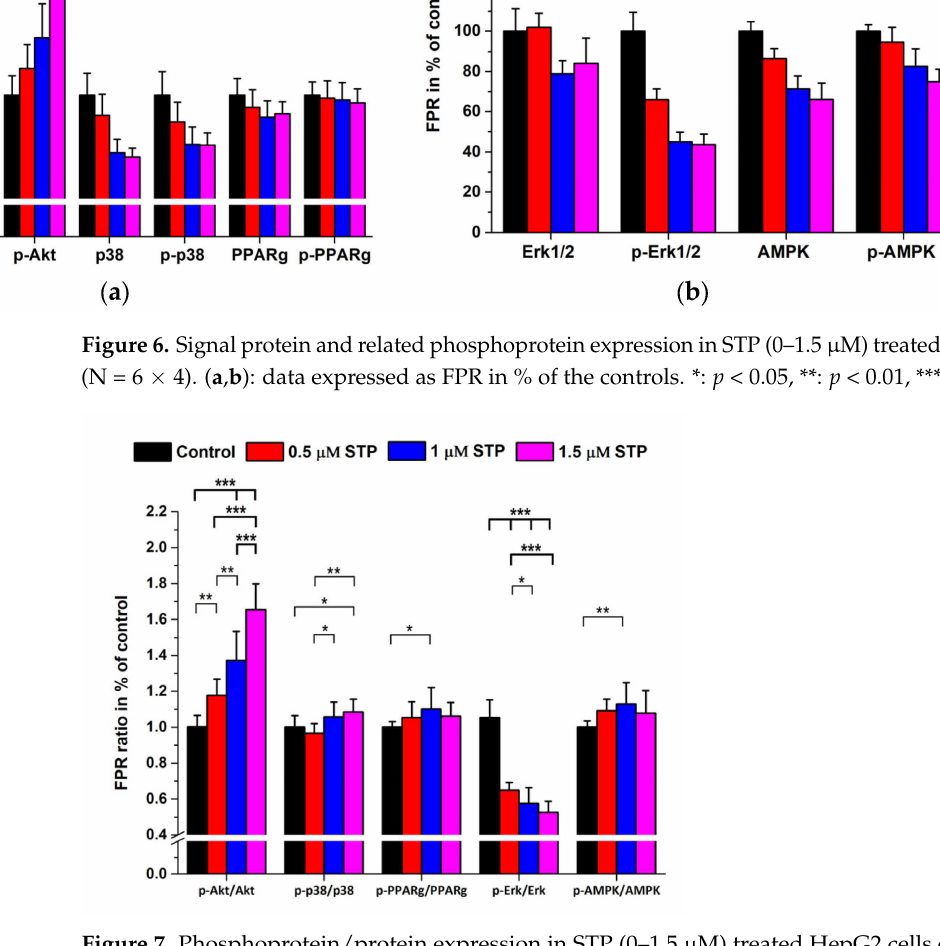
Figure 7. Phosphoprotein/protein expression in STP (0–1.5 µ M) treated HepG2 cells expressed in FPR % ratios compared with those of controls. (N = 6 × 4). *: p < 0.05, **: p < 0.01, ***: p <